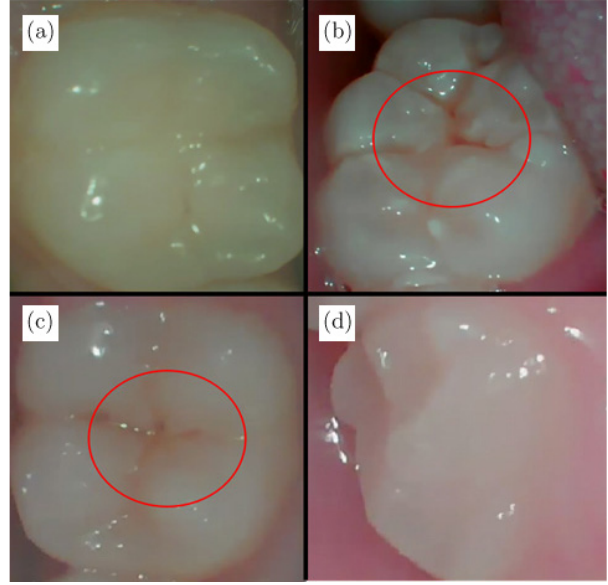
Fig. 5. Typical misclassi¯cation